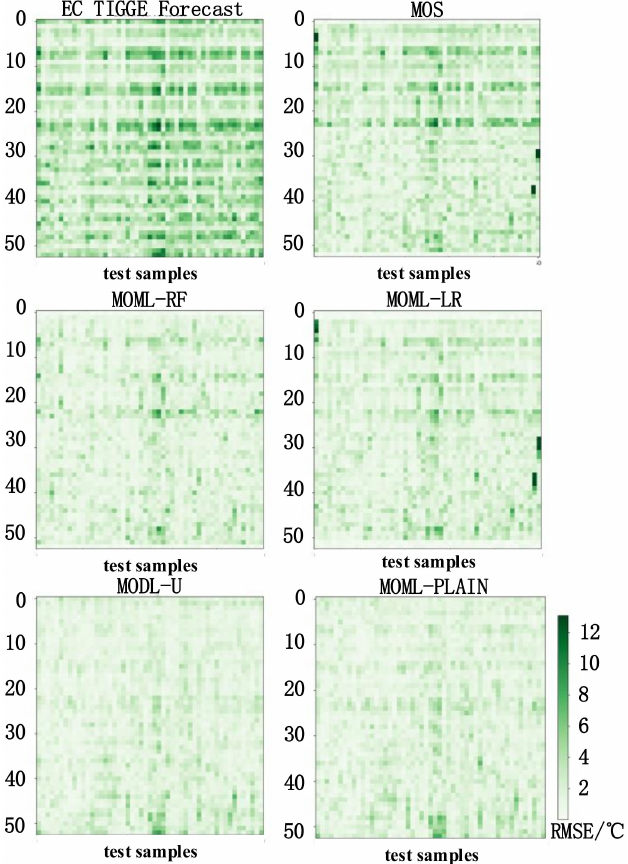
Figure 12. Comparison matrix of RMSE for di ff erent post-processing methods. The total number of samples in the test set is 1032 × 0.2 ≈ 206, including 51 dates in 12 months throughout 2017. A forecast will be made for a test date. Each time it will forecast the temperature at 53 steps in the future. Therefore, the horizontal axis of the heat map is 51 test times arranged in date order in 2017. The vertical axis is the 53 steps forecast for each forecast date. The pixel value of the heat map indicates the error between the forecast temperature and the observed temperature. The deviation evaluation index is the root mean square error